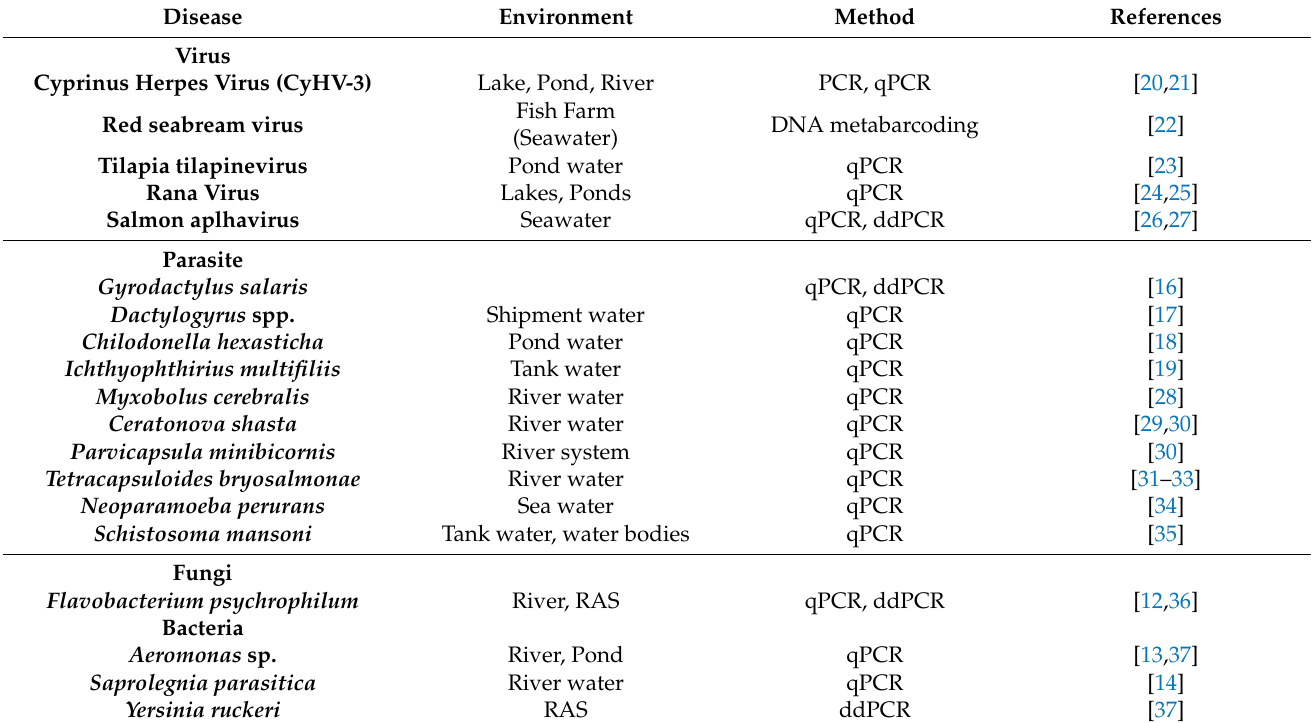
Table 1. Different fish diseases identified by eDNA/eRNA-based detection systems. The different environments, the samples collected, and the methods used to quantify are listed in the